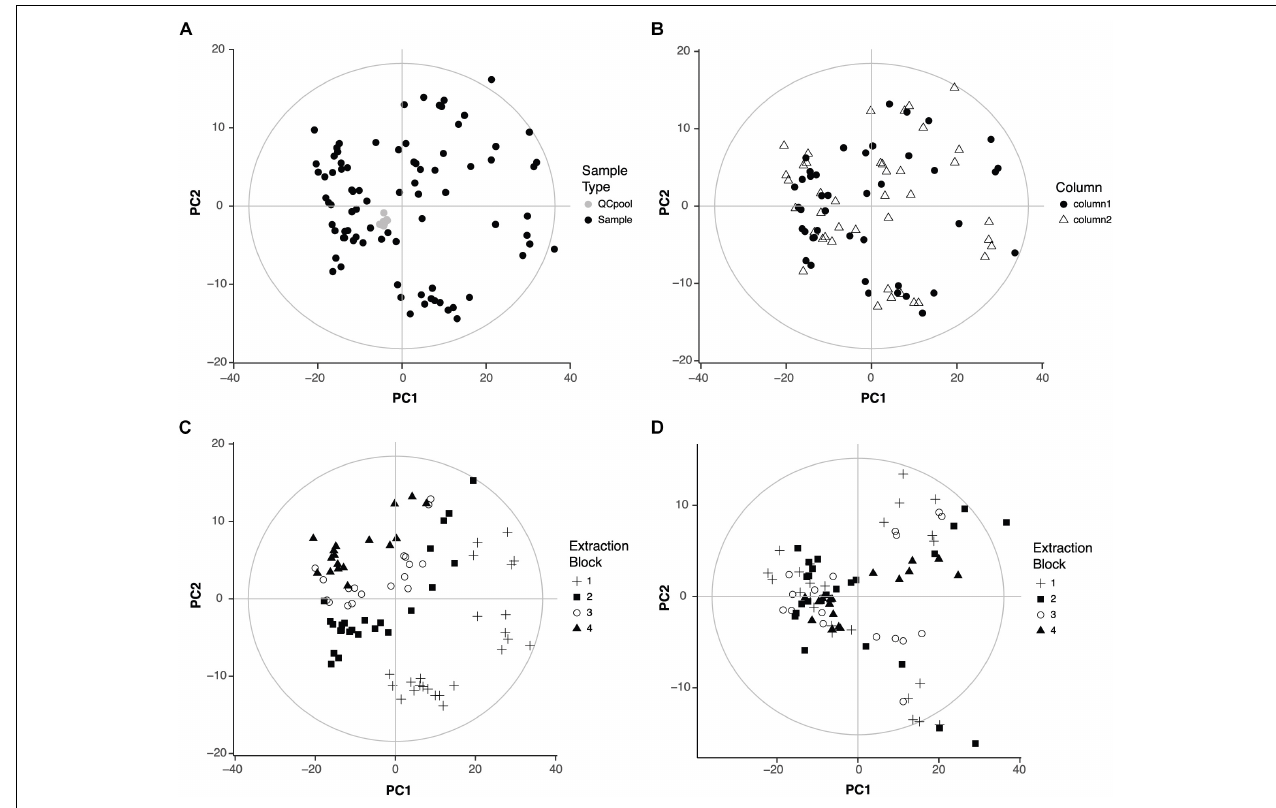
FIGURE 1 | Quality of the data. (A) Score plot of the PCA of the 95 samples that were analyzed (zebrafish samples, n = 83, QC pool, n = 12). First two components covered 47 and 12% of the variation of the data, respectively. (B) Score plot of the PCA of the 83 zebrafish samples showing the influence of the chromatographic column. First two components covered 48 and 12% of the variation of the data, respectively. (C) Score plot of the PCA of the 83 zebrafish samples showing the influence of the extraction block. (D) Score plot of the PCA after correction for the influence of the extraction block. First two components cover 46 and 8% of the variation of the data,